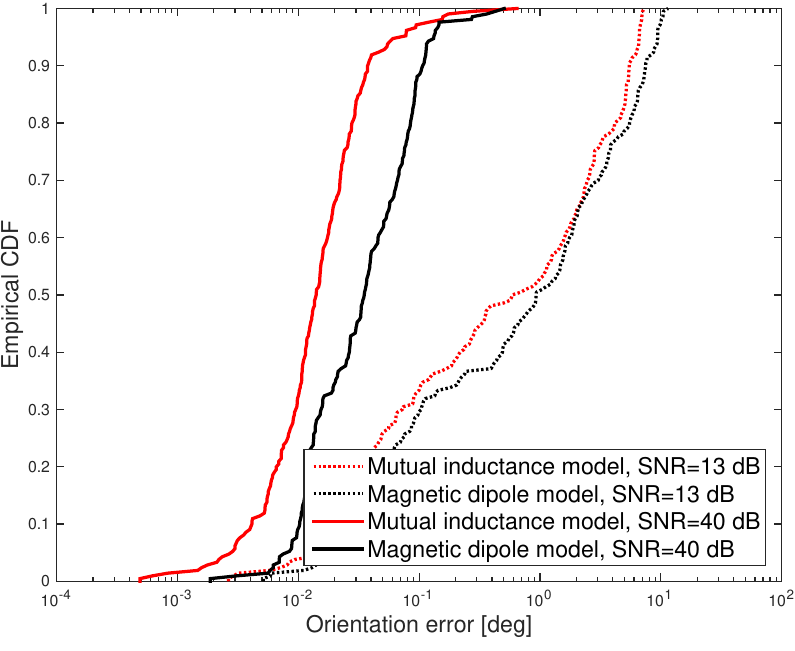
Figure 6. Simulation results: CDF of the angular error obtained for SNR = 13 dB and SNR = 40 dB.